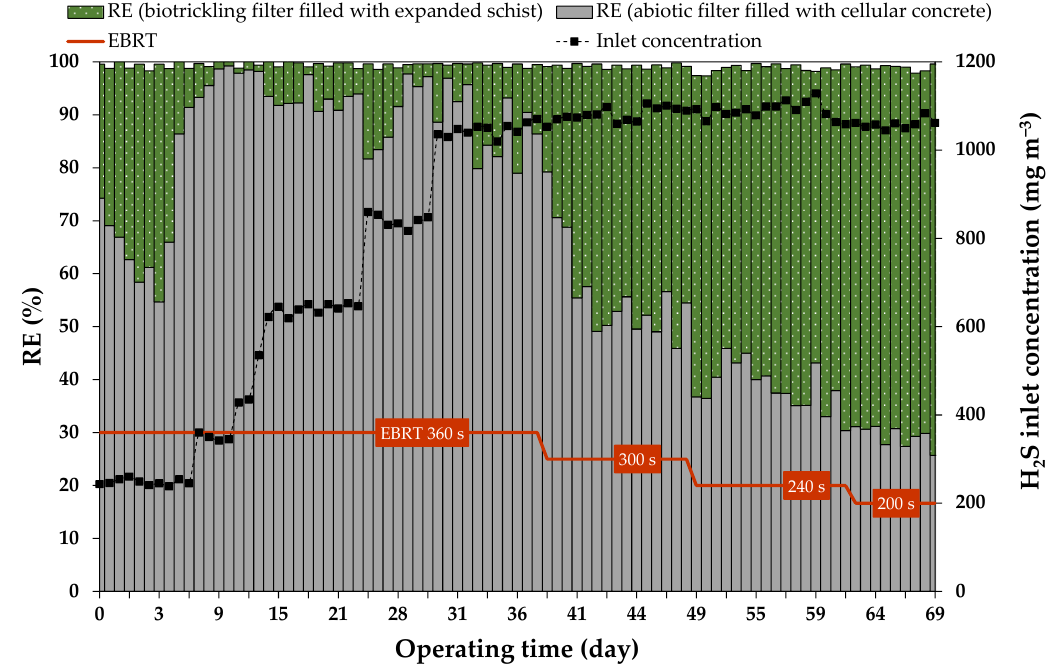
Figure 3. H 2 S removal efficiency of the two-stage process.